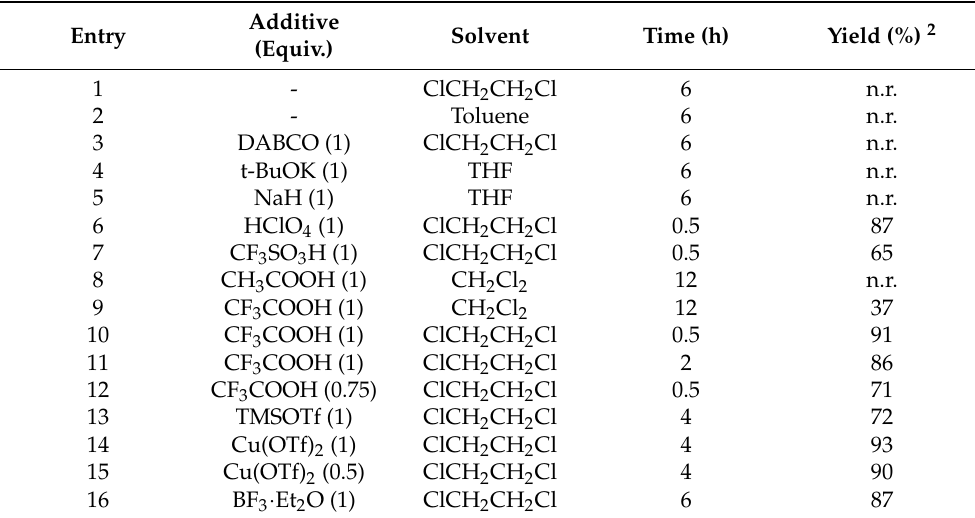
Table 1. Isomerization of amide 3a 1 .